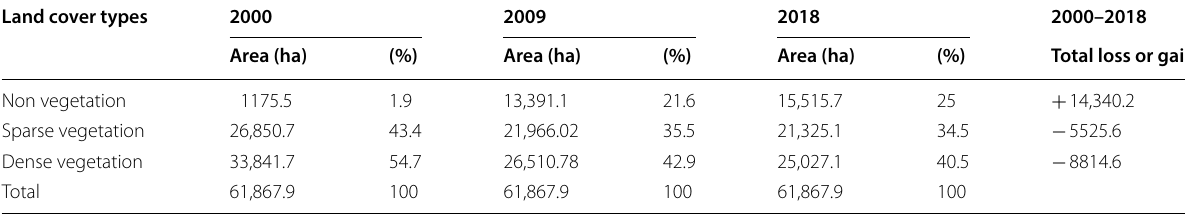
Table 7 Status of vegetation cover in Chewaka district between 2000 and 2018. Source: Computed from satellite imageries of 2000, 2009 and